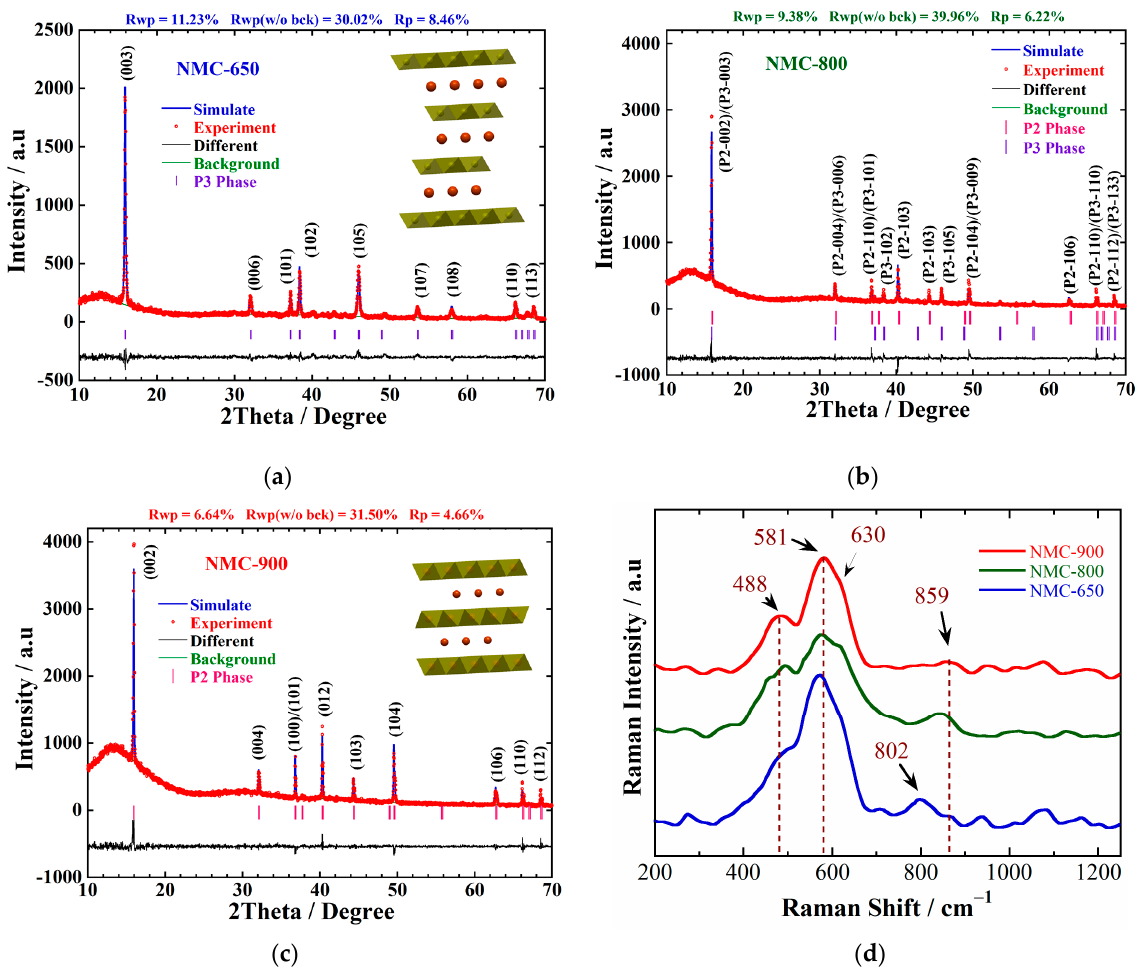
Figure 2. Rietveld refinement results of the NMC materials obtained at various calcined temperatures ( a ) NMC-650, ( b ) NMC-800 and ( c ) NMC-900, ( d ) Raman spectra of the synthesized materials. Inset of ( a , c ) shows the schematic of crystal structures of P3 and P2-type layered oxide, respectively. Table 1. Crystallographic parameters of Na x Mn 0.5 Co 0.5 O 2 materials prepared at different calcination temperatures of 650, 800 and 900 ◦